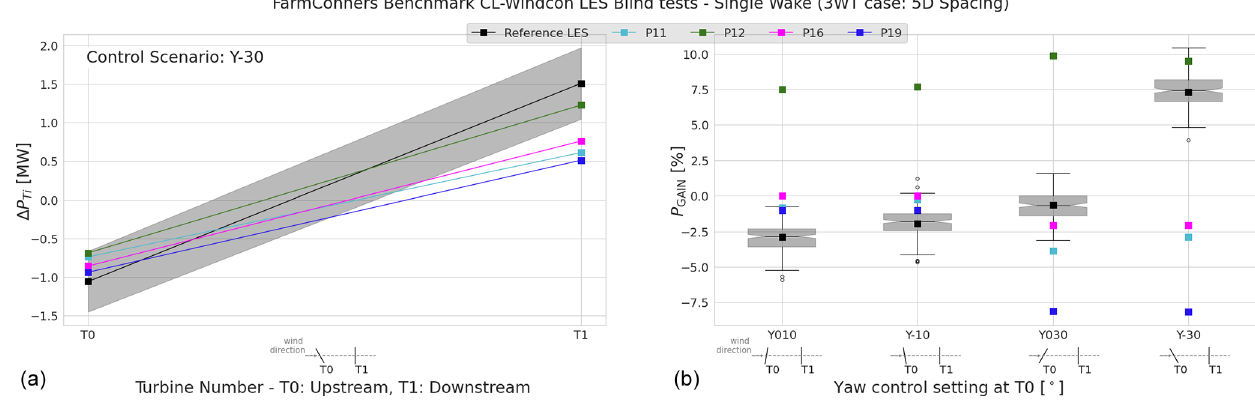
Figure 16. CL-Windcon LES blind tests, single wake under wake steering for the three-turbine configuration (3WT) with 5D spacing. (a) Power difference (mean) in absolute values (MW) per upstream (T0) and downstream (T1) turbine, when T0 is − 30 ◦ misaligned (Y-30). (b) Power gain (mean) for the two-turbine subset of the wind farm (T0 + T1). Boxplots represent the distribution of the reference CL-Windcon LES time series per control setting where T0 is steered + 10 ◦ (Y010), − 10 ◦ (Y-10), + 30 ◦ (Y030), and − 30 ◦ (Y-30). Representative layouts with corresponding yaw control settings are illustrated along the x axes.